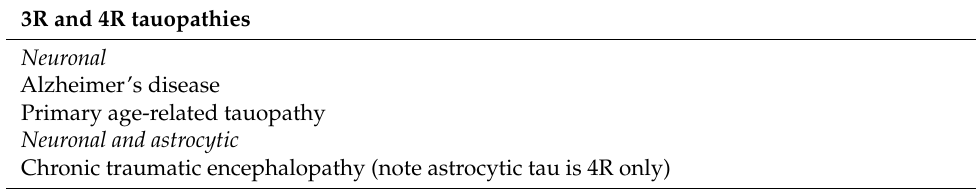
Table 1. Common 3R and 4R